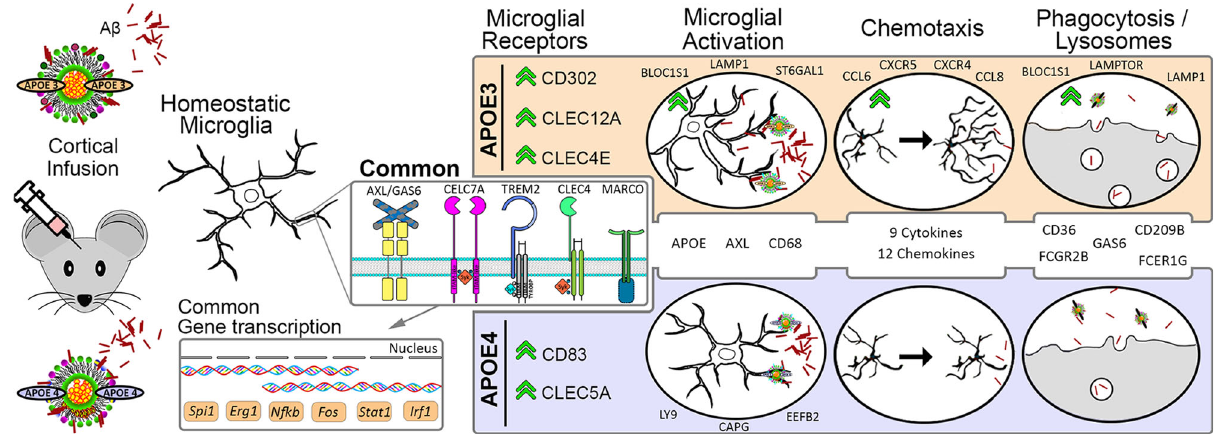
Fig. 8 Illustration of the APOE isoform-speci fi c phospholipid composition effects on microglia transcriptome and phenotype in response to A β . Shotgun and LC-MS lipidomic analysis of APOE3 and APOE4 astrocyte conditioned media identi fi ed isoform-speci fi c differences in phospholipid composition of APOE-containing lipoproteins. E3 or E4 lipoproteins co-infused with A β differentially impacted A β binding to microglia receptors (AXL, different CLECs clusters, TREM2, CD83, and others) this in turn affects genes expression of transcription factors ( Spi1 , Stat1 , Nfkb , and Irf1 ) resulting in microglia activation. Active microglia demonstrate characteristic transcriptional pro fi le, increased secretion of cytokines and chemokines thus facilitating chemotaxis and phagocytosis. Green arrows indicate an upregulation of that gene or category compared to the other APOE isoform.